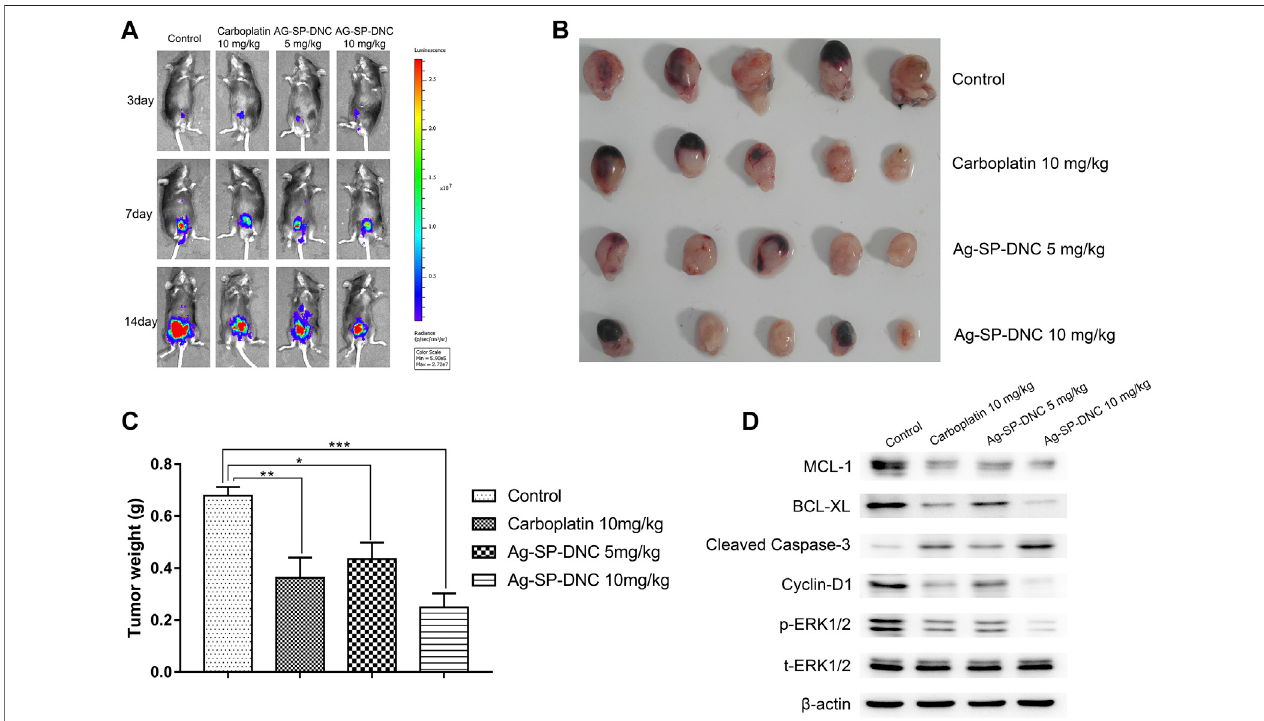
FIGURE 5 | In vivo therapy to orthotopic bladder tumors. (A) In vivo bioluminescence images of MB49 tumor-bearing mice with different treatments. (B) Photograph of all collected bladders collected on day 14 post implantation. (C) Weight of all collected bladders collected on day 14 post implantation. Data are expressed as the mean ± SEM; n (cid:1) 5. * p < 0.05, ** p < 0.01, *** p < 0.001. (D) Western blot of MCL-1, BCL-XL, cleaved caspase-3, Cyclin D1, ERK1/2 phosphorylation and total ERK1/2 levels of MB49 tumors. Tumors were excised and homogenized in lysis buffer on day 14